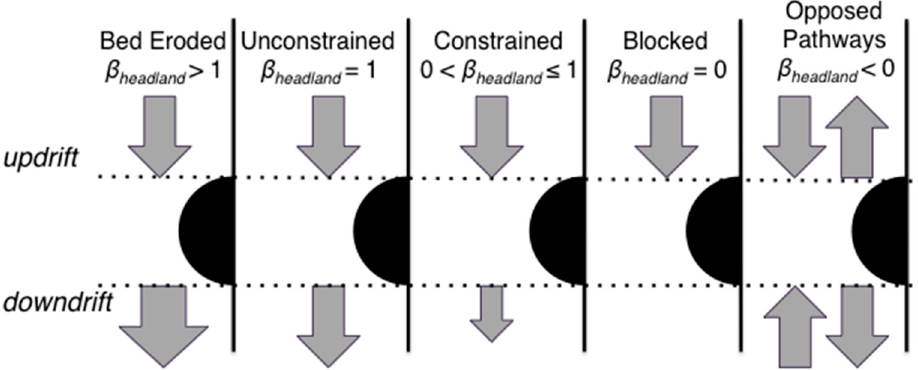
Figure 4. Schematic depicting categories of β headland as defined in Equation (13).